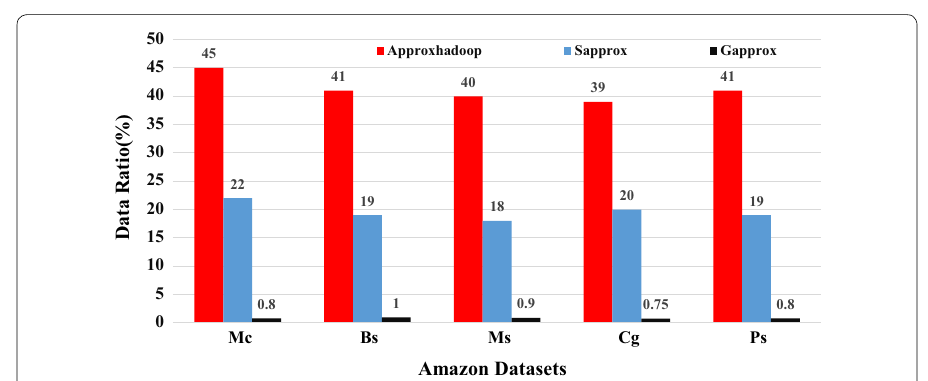
Fig. 9 Amount of data must be processed to achieve the sampling requirements (Amazon datasets)